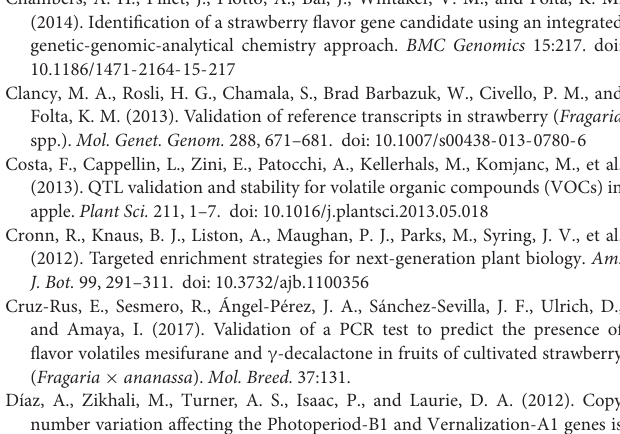
Supplementary Figure 1 | Super pool screening of BAC libraries AH3, BB1, and BH3 with two gene based markers, qFaFAD1 and UFGDHRM5. The numbers